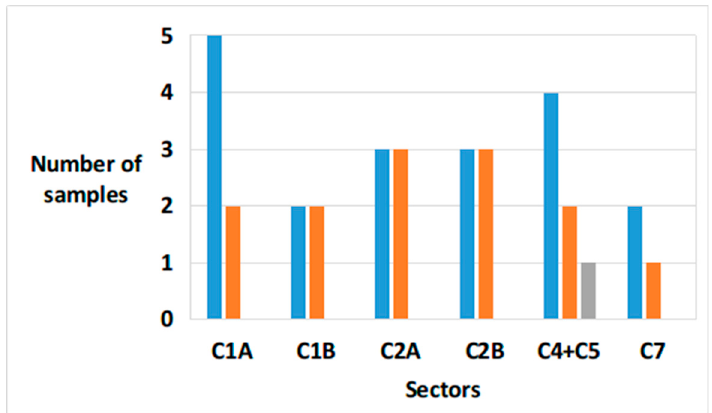
Figure 4. Number of sampled sites for water quality analysis per sector and water bodies: Irrigation ( ), Drainage ( ), and Groundwater ( ), in 2018.